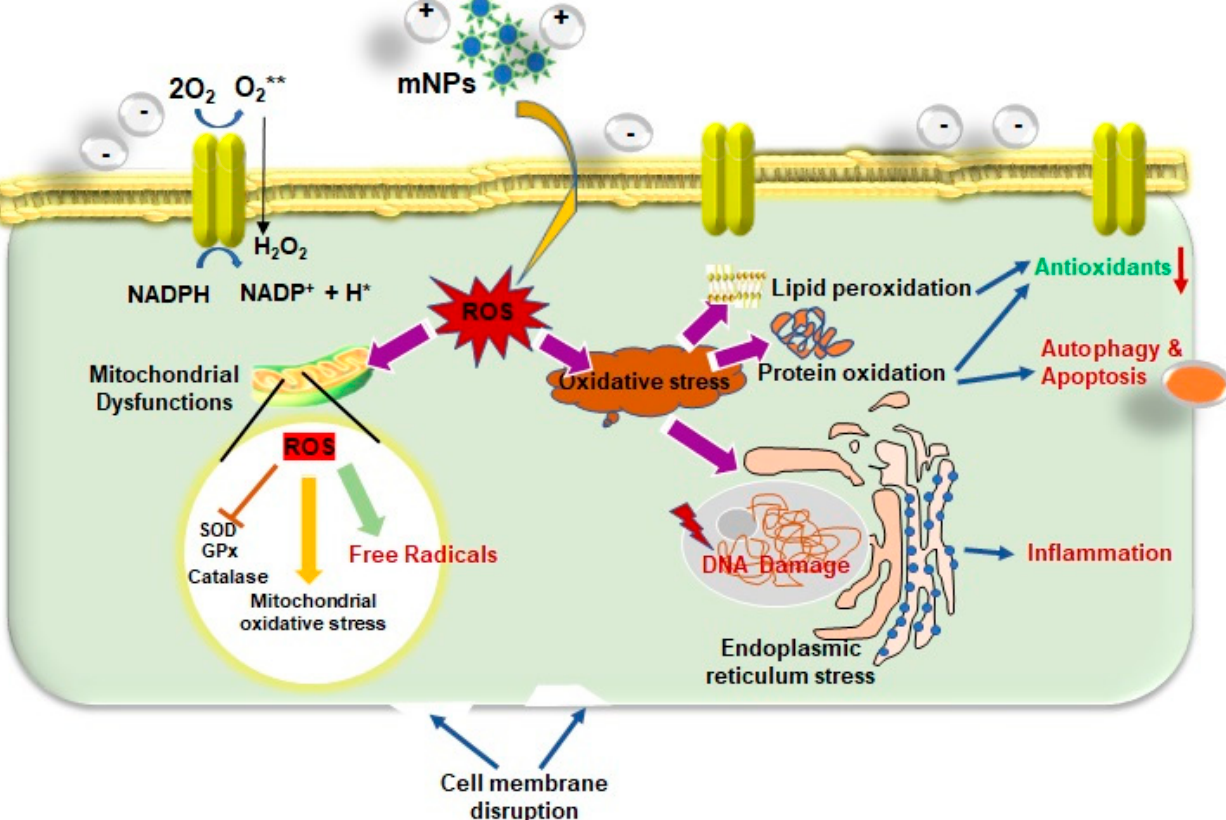
Figure 4. A schematic representation of the numerous triggers involved in forming reactive oxygen species (ROS) and the ROS induced pathways that lead to cell damage. Oxidative stress has a significant impact on nanotoxicity. The active surface of the nanoparticle, the size of the nanoparticle, photoactivation, toxins, metal ion dissolution, and nanoparticle interactions with biomolecules are all features that contribute to the generation of nanoparticle induced ROS.